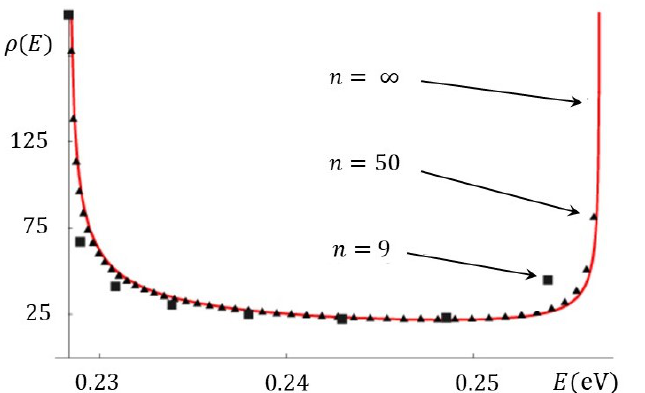
Figure 6. The discrete and continuous energy-level densities. As the number of unit cells n tends to ∞ , the discrete density of energy levels of the TFPS tends to the continuous density of levels derived by Kronig and Penney.